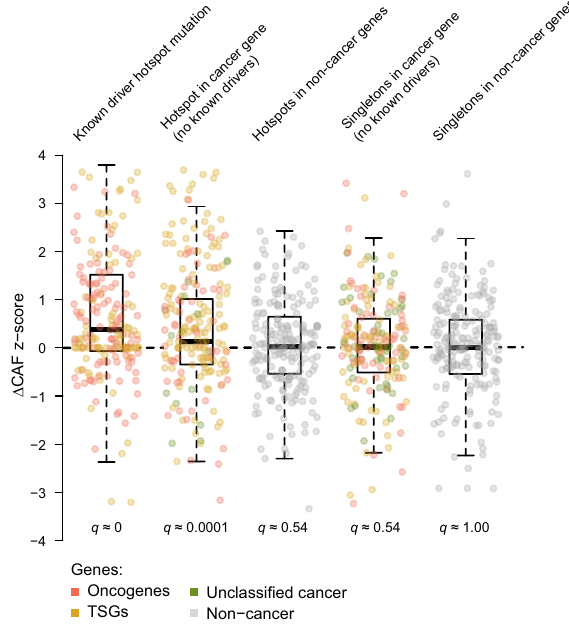
Fig. 3 Boxplot of Δ CAF z-score distributions. One boxplot for each group of SNV hotspots with four or more mutations and singletons in the protein-coding region; the fi rst boxplot is known driver hotspots; the second is hotspots in cancer genes excluding driver positions; the third is hotspots in other genes; the fourth is all singletons in cancer genes excluding driver positions; the last is all singletons in other genes; dots are 200 randomly sampled hotspots/singletons for each boxplot; the centerline of each box is the median of the distribution; the lower bound of the box is the fi rst quartile (Q1); the upper bound of the box is the third quartile (Q3); the lower whisker shows the minimum value greater than Q1 − 1.5x IQR; the upper whisker shows the maximum value smaller than Q3 + 1.5x IQR. IQR: interquartile range (Q3 – Q1); CAF: cancer allele fraction; TSGs: tumor suppressor